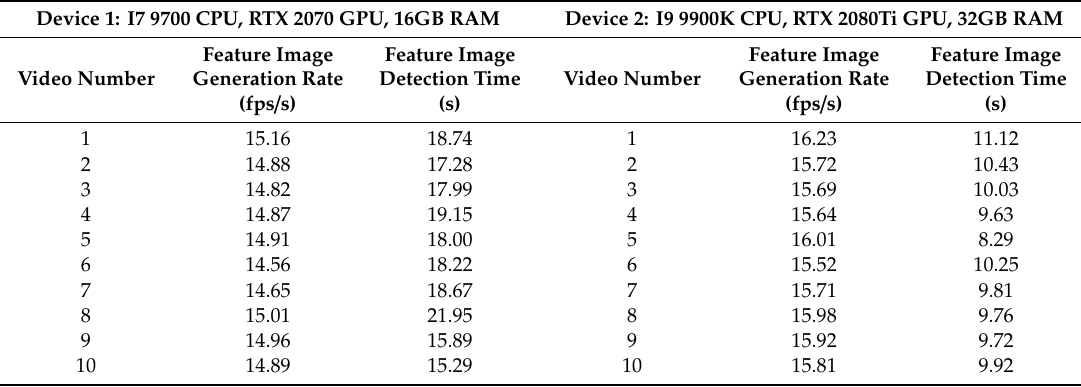
Table 6. The performance of the